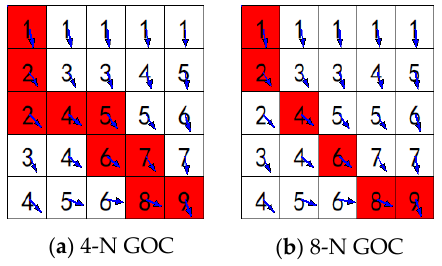
Figure 6. Example of gradient orientation clustering (GOC). The blue arrow represents the gradient orientation of a point and the red squares represent the clustering path.